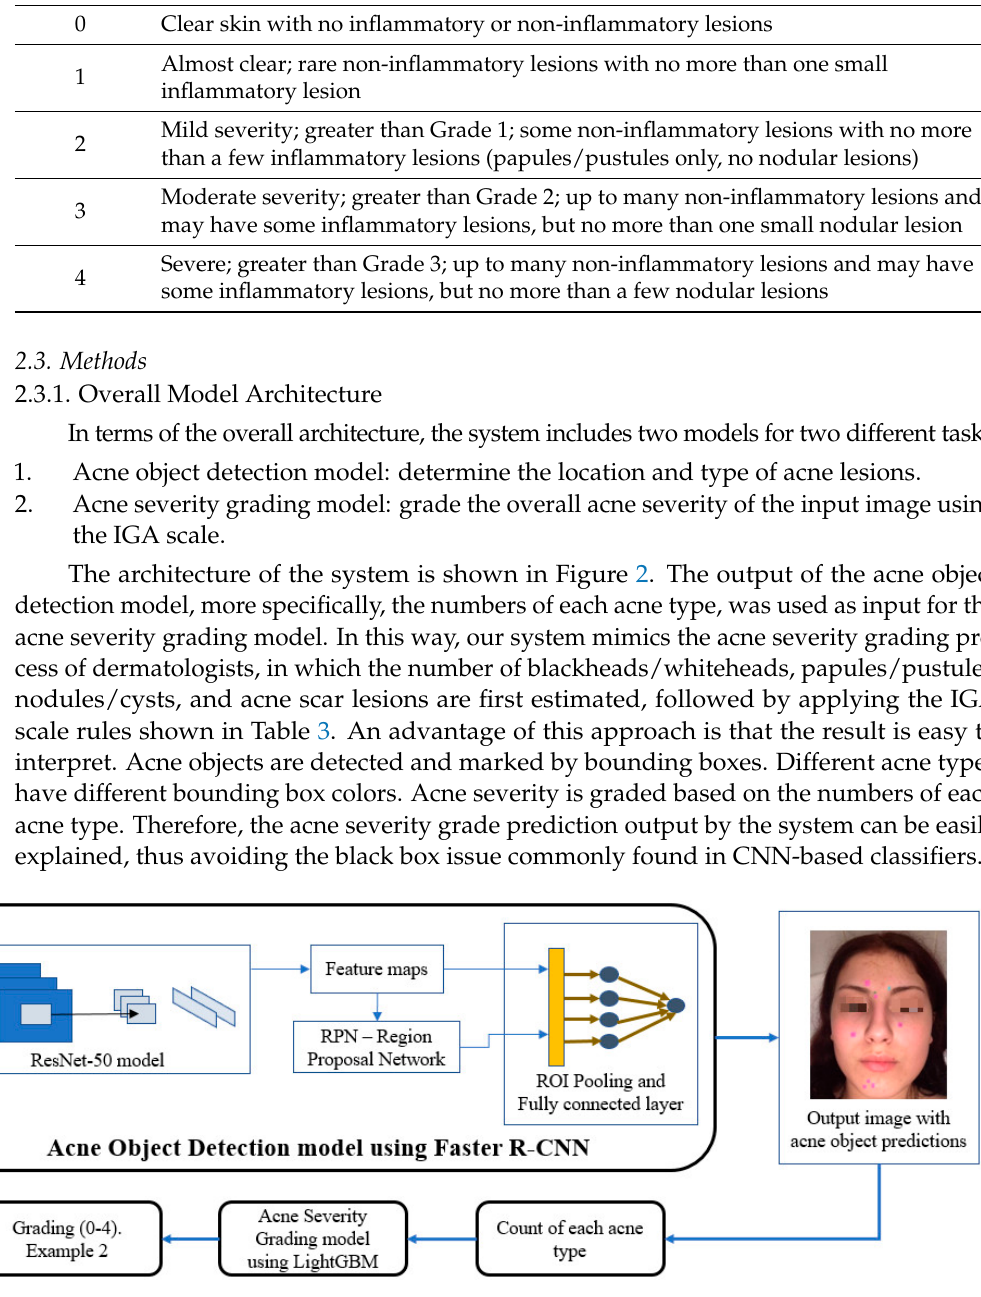
Figure 2. Pipeline of acne lesion object detection and acne severity grading system with two main steps: acne object detection and acne severity grading. The output of the acne object detection model was used as input to the acne severity grading model.